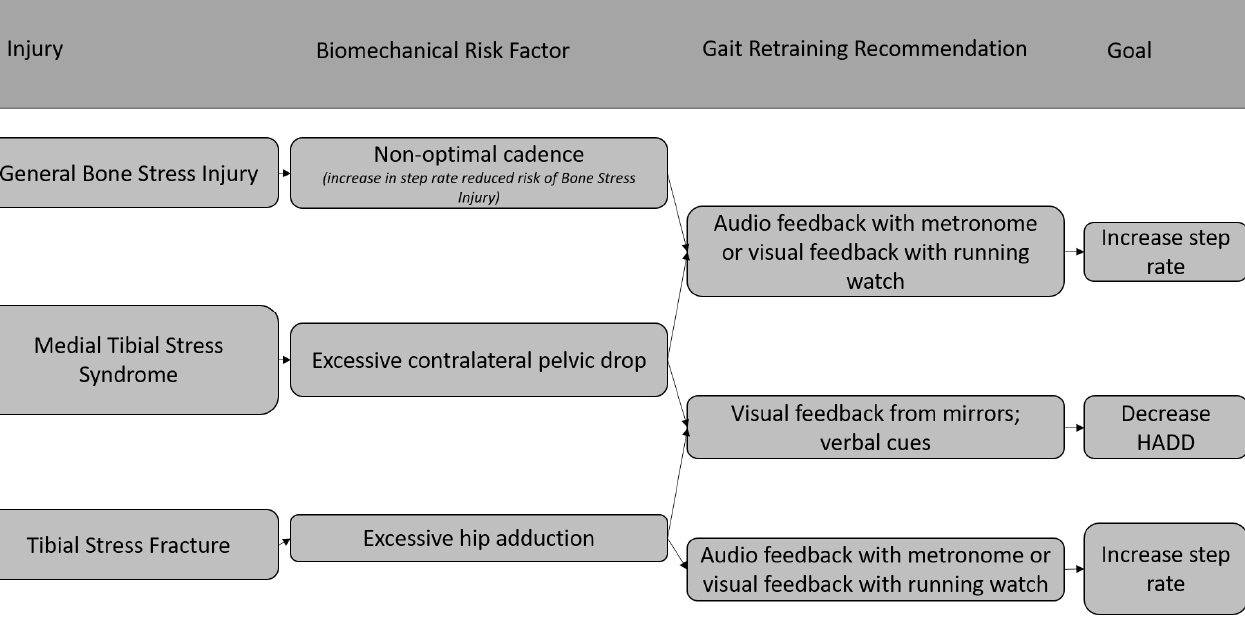
Figure 1. Examples of using gait retraining to treat bone related RRIs [22,30,32,61,62].